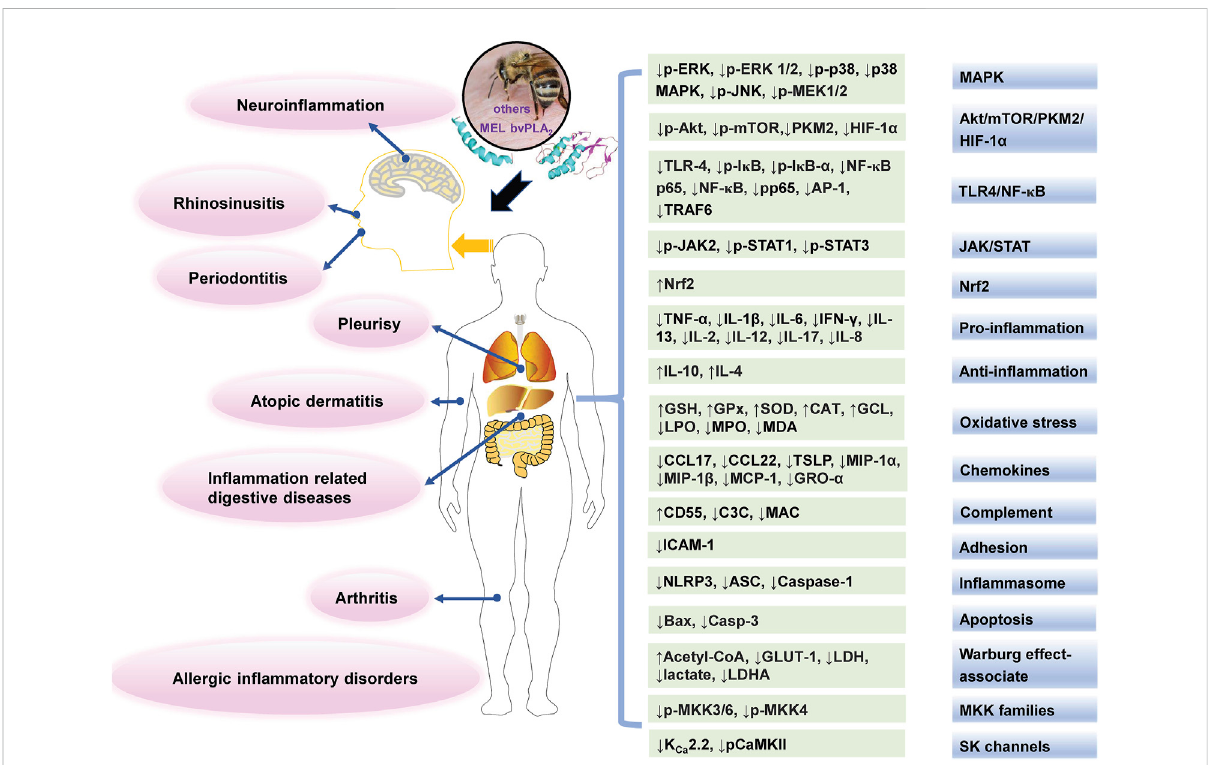
FIGURE 4 The main affected targets and mechanisms of BV and its main components in alleviating in fl ammatory diseases. The texts in pink oval boxes, light grey green boxes, and gradient grey blue boxes indicate related diseases, regulated targets and pathways (or mechanisms),